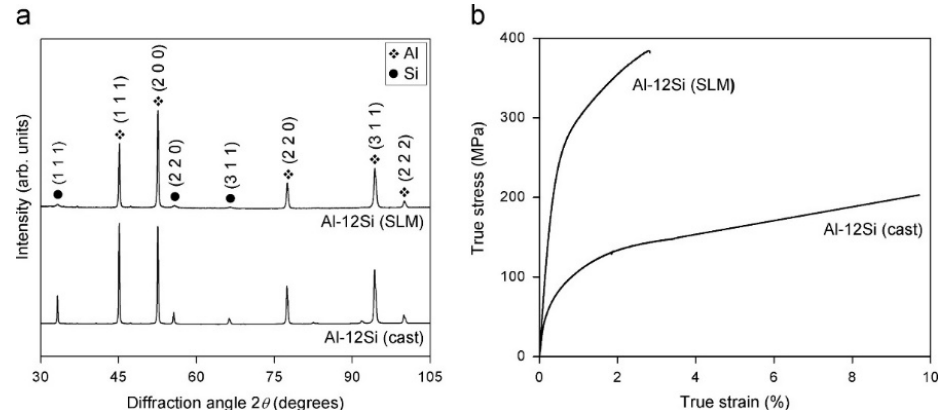
Figure 25. ( a ) XRD patterns (λ = 0.17889 nm) and ( b ) room temperature tensile tests of cast and